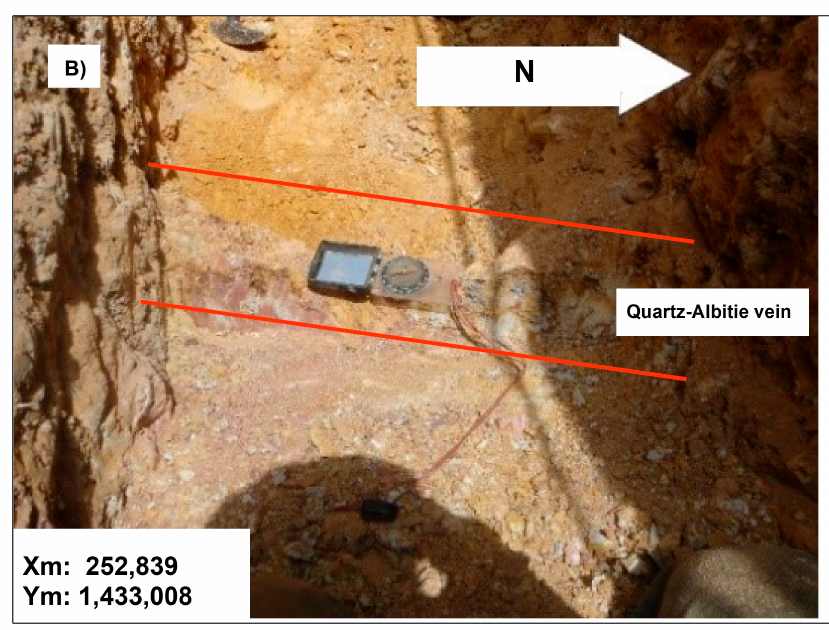
Figure 7. Quartz–albite veins. ( A ) Sample showing arsenopyrite. ( B ) Veins’ orientation near the fold zone.